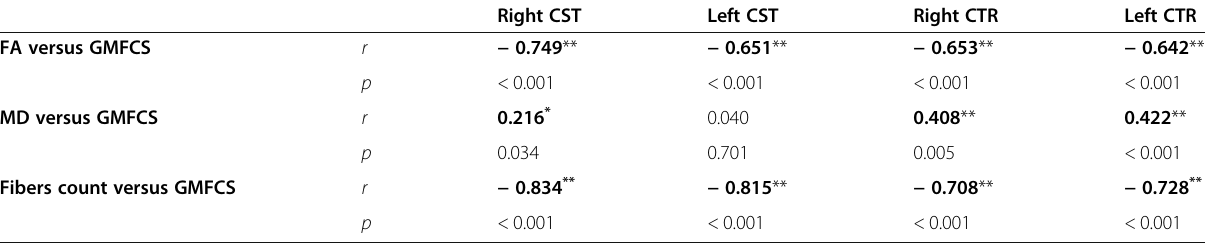
Table 3 Correlations between clinical motor grade and diffusion tensor imaging metrics (fractional anisotropy, mean diffusivity, and fiber count) of motor corticospinal and sensory corticothalamic tracts in cerebral palsy children (no =